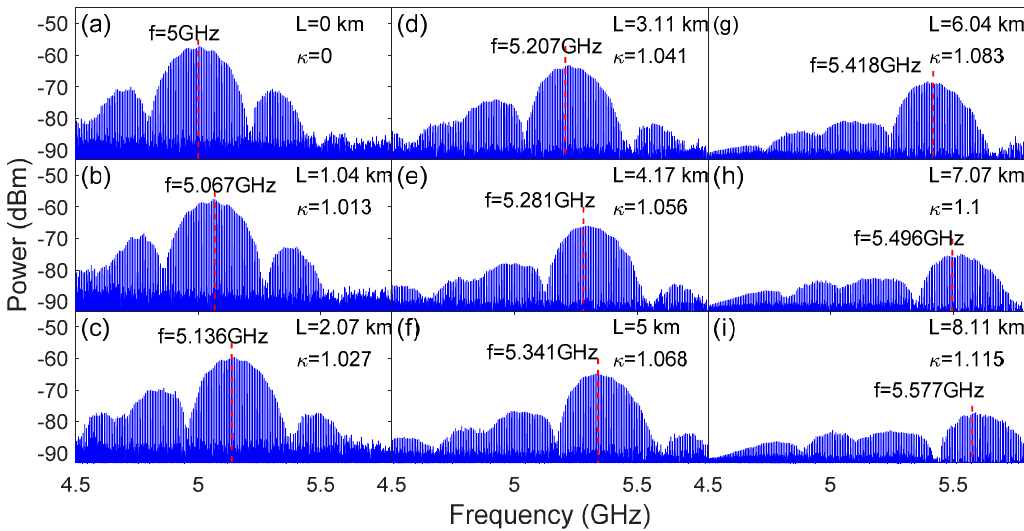
Figure 8. ( a – i ) The electrical spectrum of the up conversion when the SMF was 0 km, 1.04 km, 2.07 km, 3.11 km, 4.17 km, 5 km, 6.04 km, 7.07 km and 8.11 km.